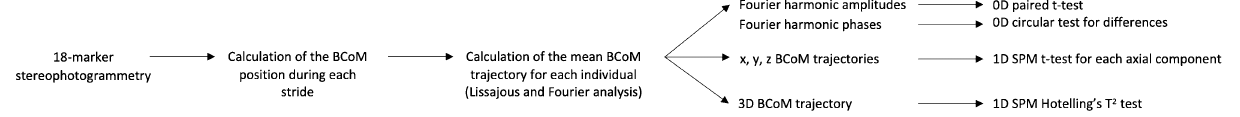
Figure 1. Data analysis and statistics flowchart. BCoM: body centre of mass. 3D: three-dimensional. 0D: Zero- dimensional. 1D: